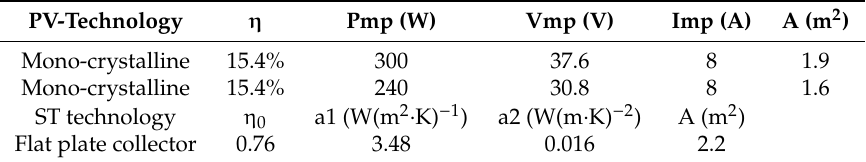
Table 3. PV panel and solar thermal plant (ST) collector features by technical datasheet .